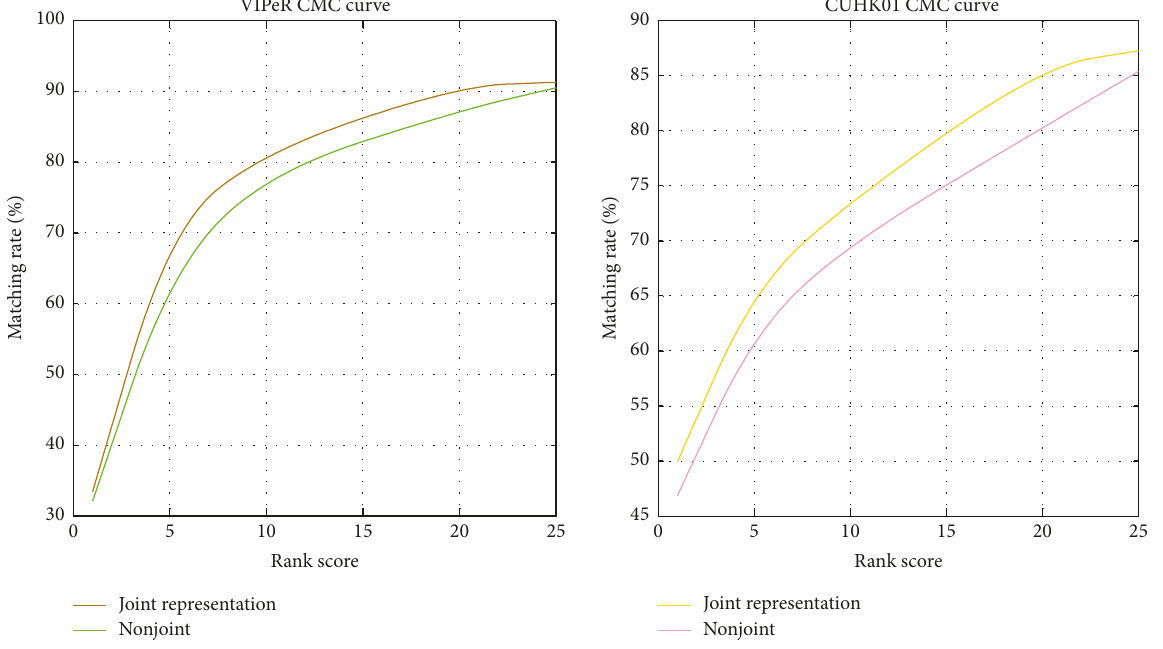
Figure 6: Performance comparison with two branches input method using CMC curves on VIPeR and CUHK01 datasets.